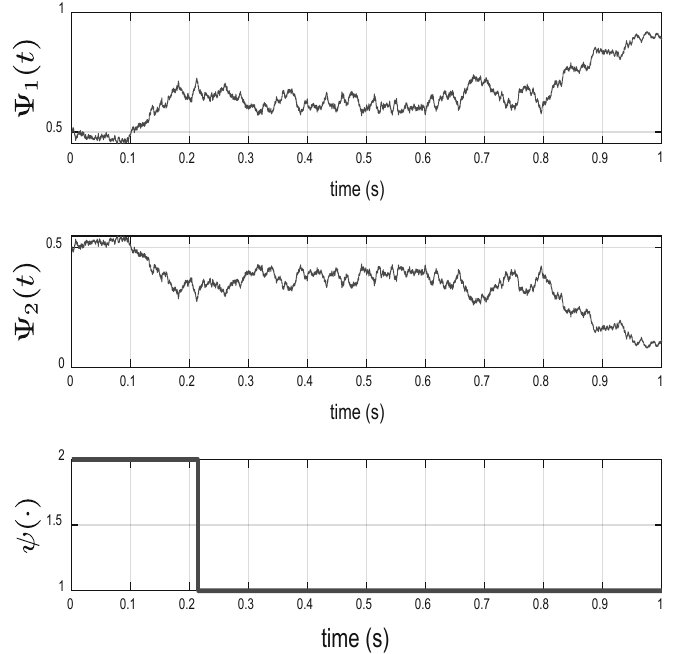
Figure 1. Wonham filter for the α -discounted